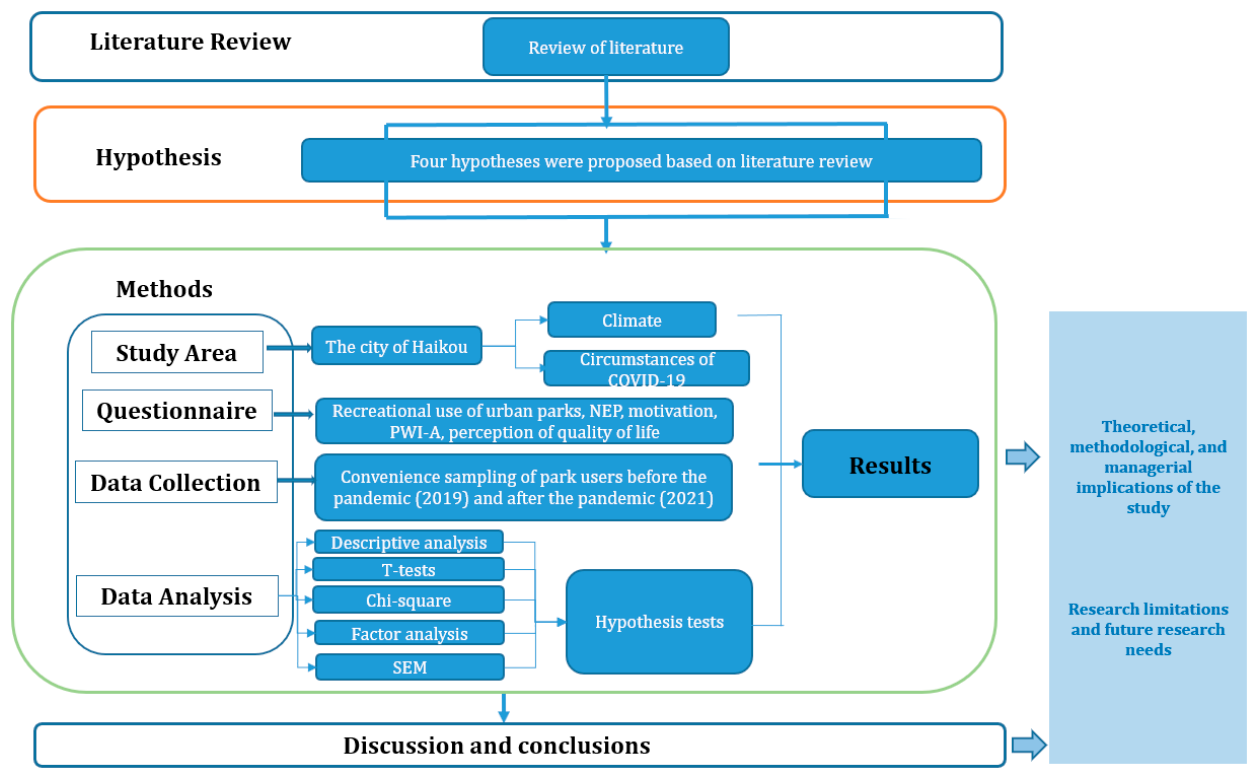
Figure 1. A schematic flowchart of the study.